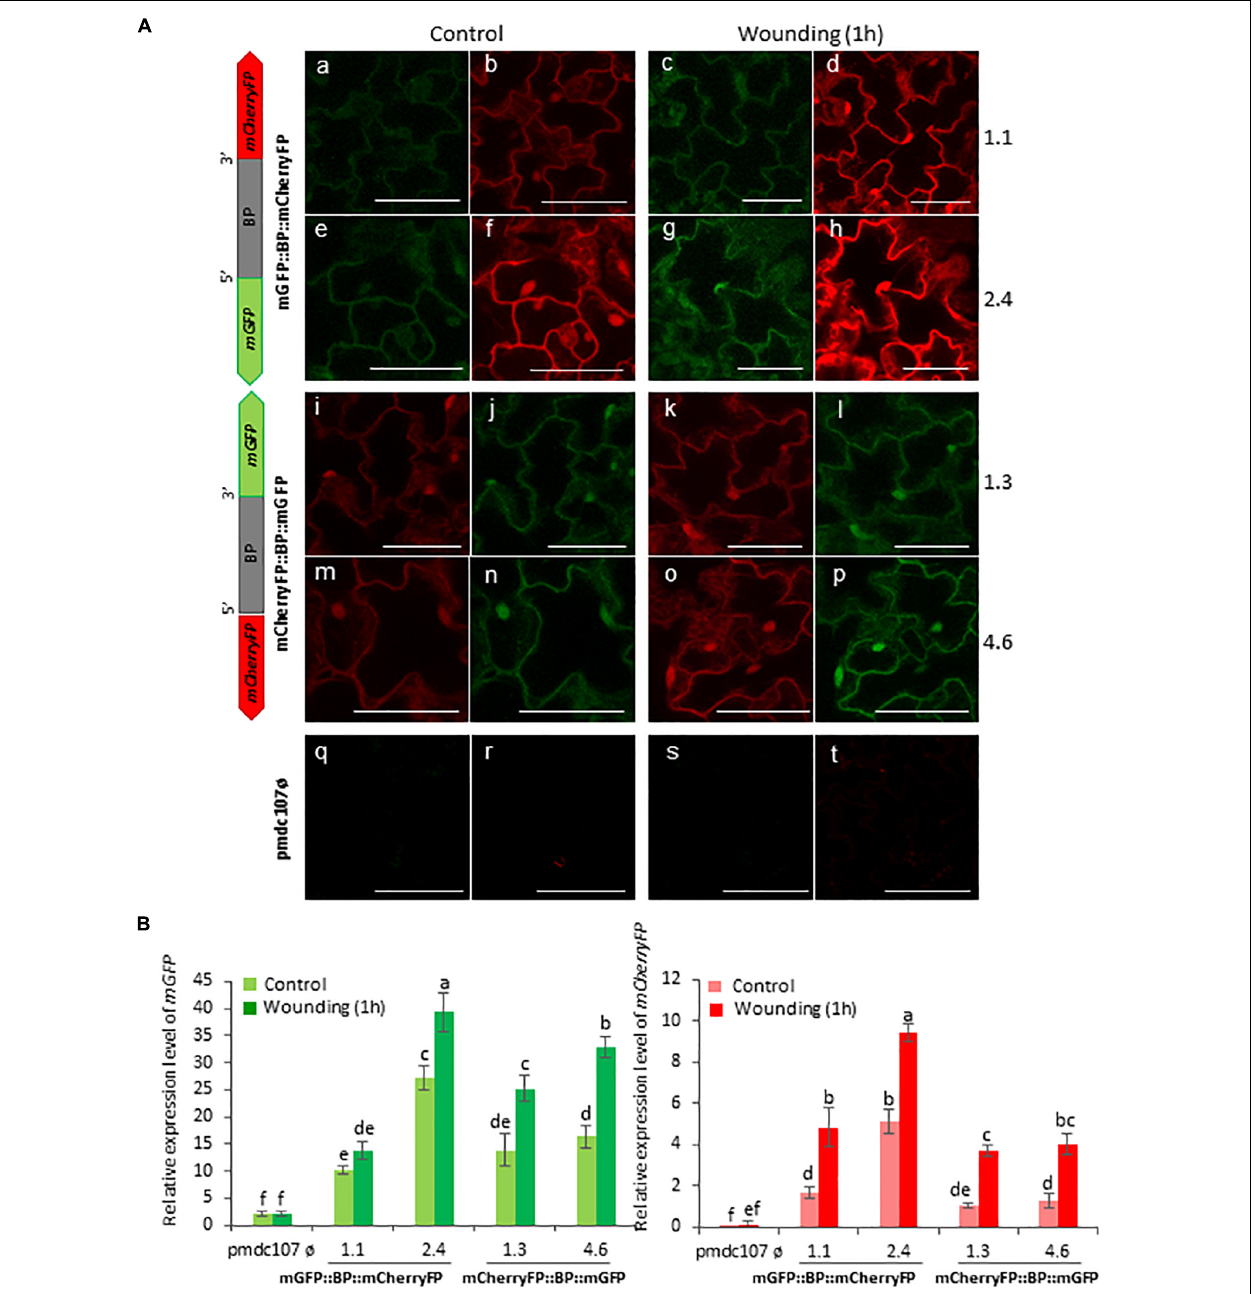
FIGURE 6 | Schematic representation of fusion-constructs and expression assays in stably transformed Arabidopsis plants in response to wounding. (A) Scheme of mCherryFP and mGFP genes driven by the bidirectional promoter (BD) and confocal stacks spanning Arabidopsis epidermal cells of transformed plants after 1 h of wounding. Projections are from mCherryFP (b,d,f,h,i,k,m,o,r,t) and mGFP (a,c,e,g,j,l,n,p,q,s) . Bars are 50 µ m. (B) Quantitative analyses of mGFP and mCherryFP expression by RT-qPCR in Arabidopsis transformed plants after 1 h of wounding. Bars in green and red colors correspond to mGFP and mCherryFP gene expression, respectively. Data are ± SE of three biological replicates. Differential letters indicate statistical differences ( P < 0.05 Wald χ 2 followed by LSD test). Arabidopsis selected lines for mGP::BBP::mCherryFP construct were 1.1. and 2.4, and for mCherryFP::BD::mGFP were 1.3 and 4.6. Primers used for this experiment are listed in Supplementary Table 1